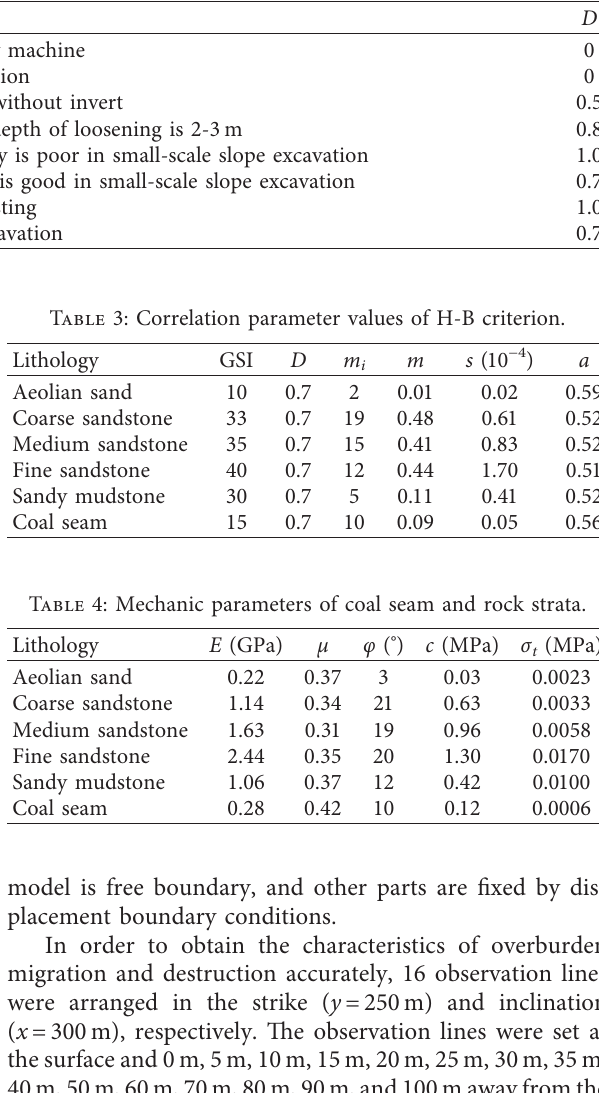
Table 2: Value of excavation disturbance parameter D .